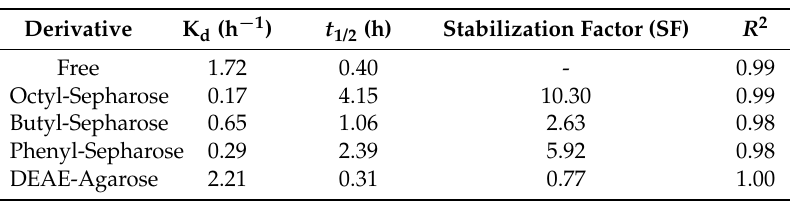
Table 4. Kinetic parameters of free and immobilized M. spathulata R25L270 lipase thermal stability at 60 °C and pH 7.0.